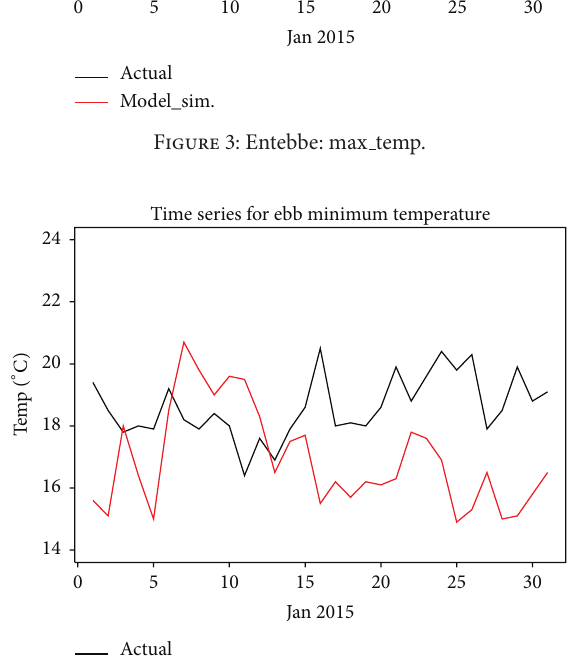
Figure 4: Entebbe: min